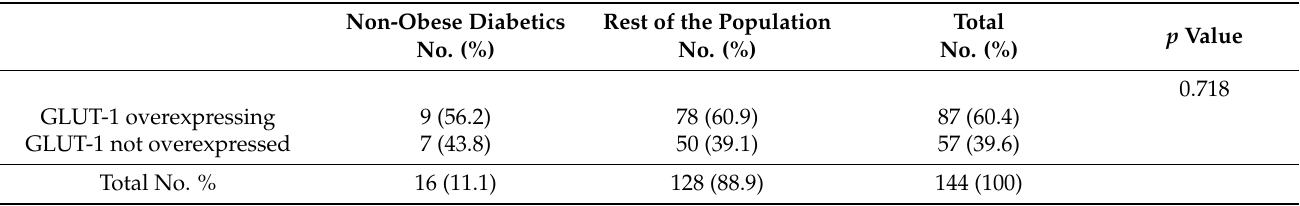
Table 9. Comparison of GLUT-1 overexpression between non-obese diabetic patients and the general